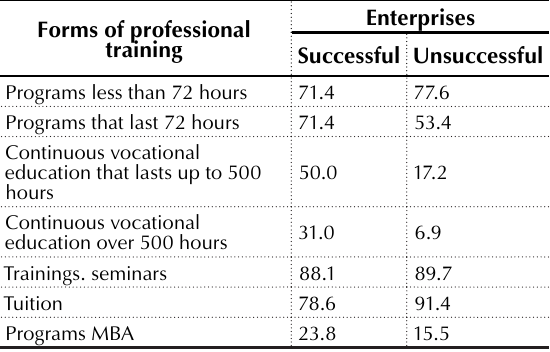
Table 1. Used forms of additional education at continuous vocational education of successful (innovative) and unsuccessful enterprises in 2015,